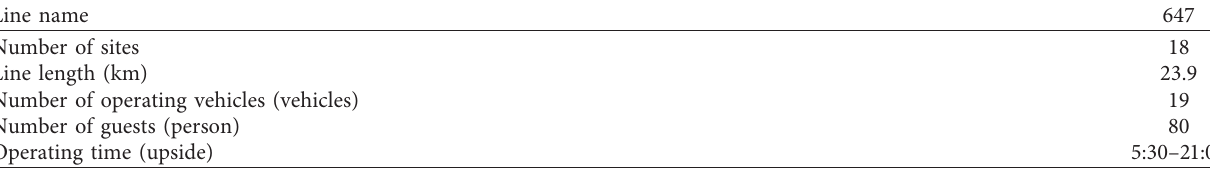
Table 2: Basic operation data of the No. 647 bus.